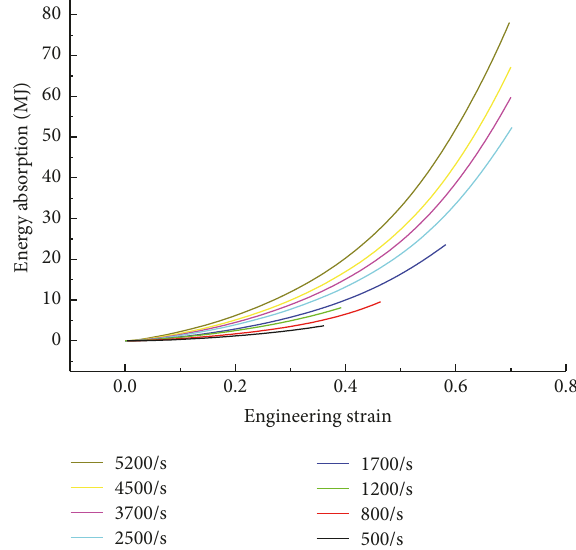
Figure 9: Energy absorption curves of high-damping rubber.